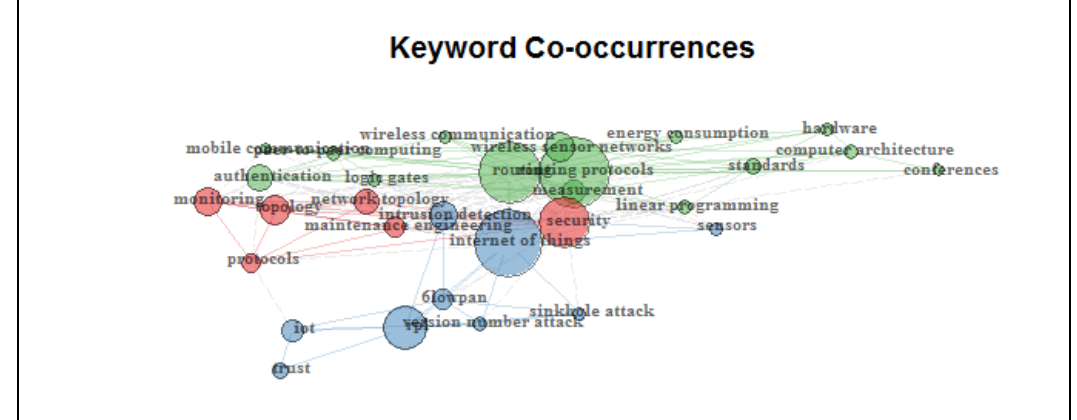
Figure 7. Keyword co-occurrences.